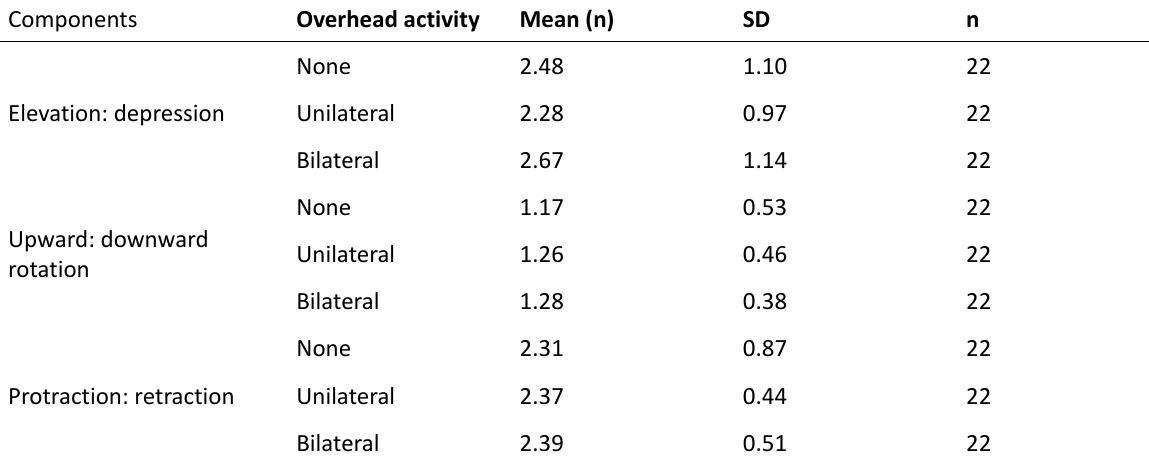
Table 4. Ratio Comparison as Grouped by Overhead-Activity Level